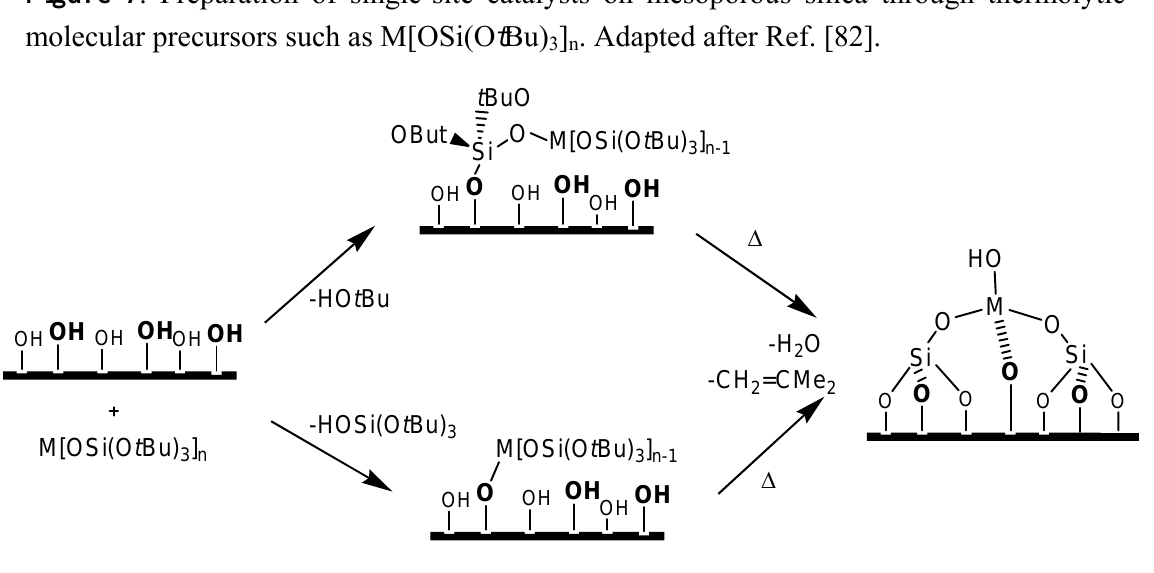
Figure 7 . Preparation of single-site catalysts on mesoporous silica through